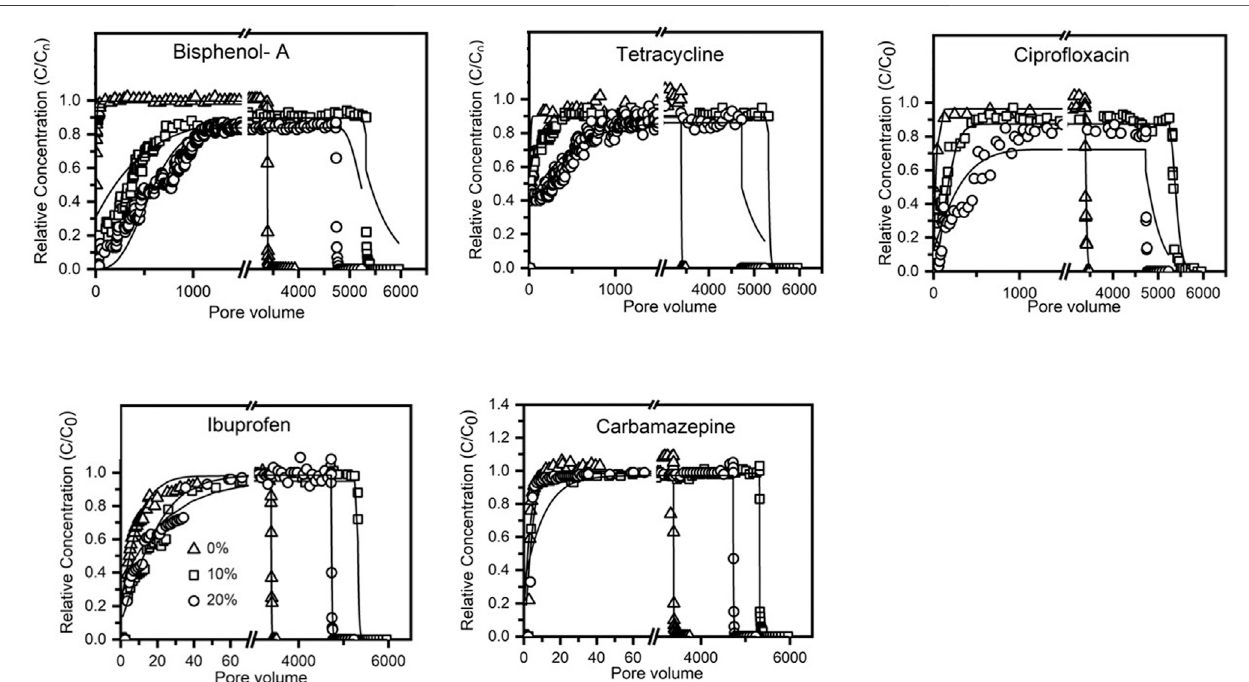
FIGURE 3 | Flushing of PPCPs with low surface tension solution (20% v/v ethanol added to the background solution) from 0, 10, and 20% birnessite-coated sand columns.